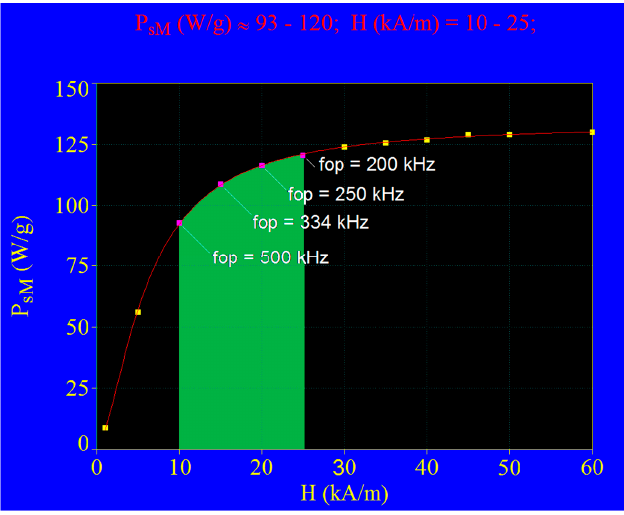
Figure 7. The maximum specific loss power variation with the amplitude of magnetic field within the biologically admissible limit; fop is the optimal limit frequency that gives the highest power depending on the magnetic